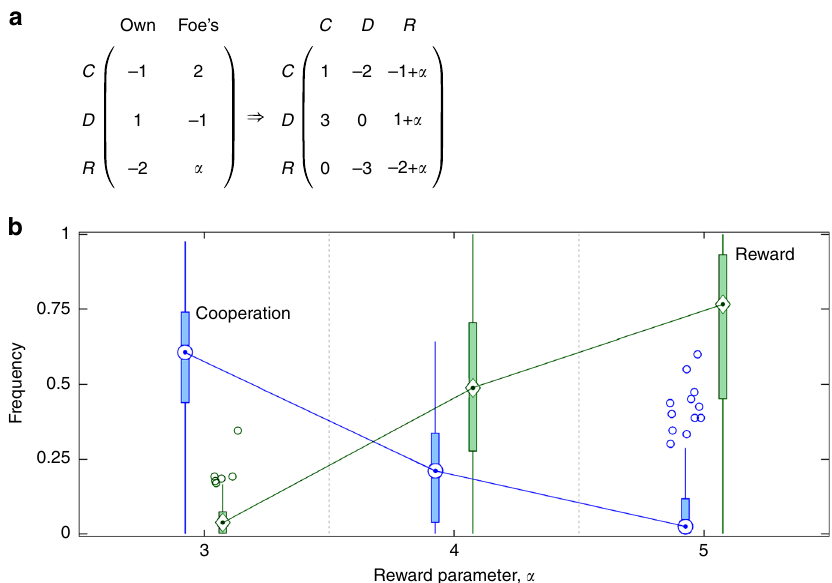
Fig. 6 Decoy ’ s relevance is perceived correctly. a Payoff matrix generalised with the reward parameter, α . Our interpretation of the results was predicated on the correct perception of the decoy as an inferior option. To test whether this was true, we increased the reward parameter from α = 3 to α = 4 to α = 5, thus decreasing the dilemma strength of the ( D , R ) pair from DS = 3 to DS = 1.5 to DS = 1, respectively. In the process, cooperation C was expected to switch places with reward R as the inferior option because dilemma strength of the ( C , D ) pair is DS = 2. b Our expectation is mirrored in the experimental data as the median frequency of C falls from 60.5% for α = 3 to 2.5% for α = 5, while the median frequency of R goes up from 3.7% for α = 3 to 76.5% for α = 5. For α = 4, similar dilemma strengths of ( D , R ) and ( C , D ) pairs (DS = 1.5 vs. DS = 2, respectively) make the distinction between C and R somewhat opaque. With the median frequency of C at 21.1% and R at 48.8%, the data seem to re fl ect a certain degree of confusion. Despite this confusion, R is more prevalent than C , which is in agreement with the slightly more favourable dilemma strength of the former option. The plot is a compact variant of the box- and-whisker plot in Fig. 1 and carries similar information content (medians, interquartile ranges, minimum and maximum values, and outliers if